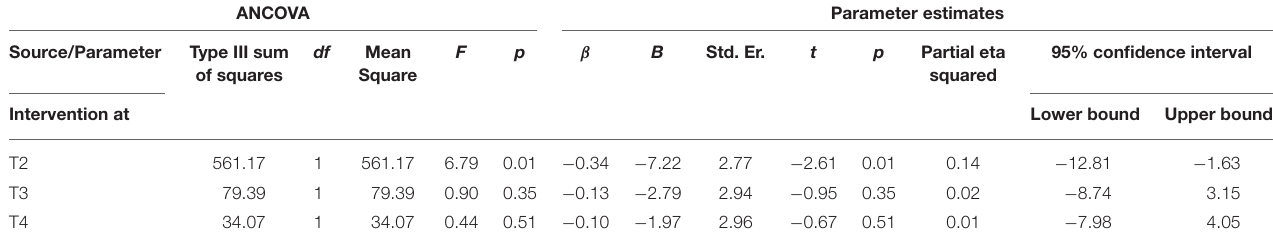
TABLE 6 | Effects of the Intervention at T2, T3, and T4.